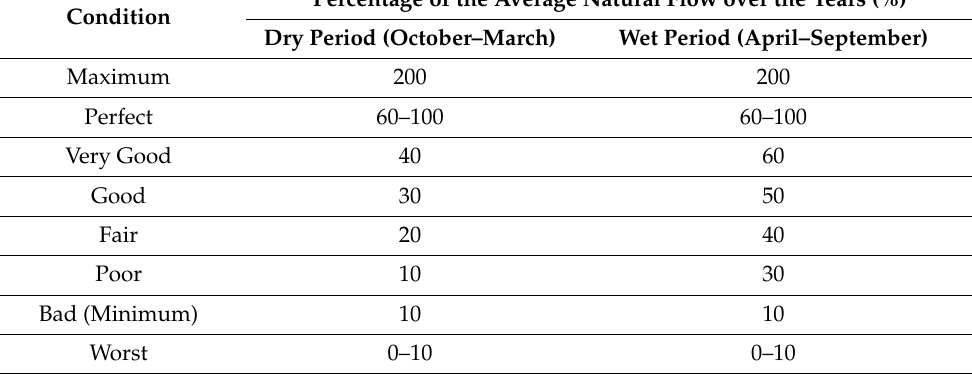
Table 1. Evaluation criterion of different